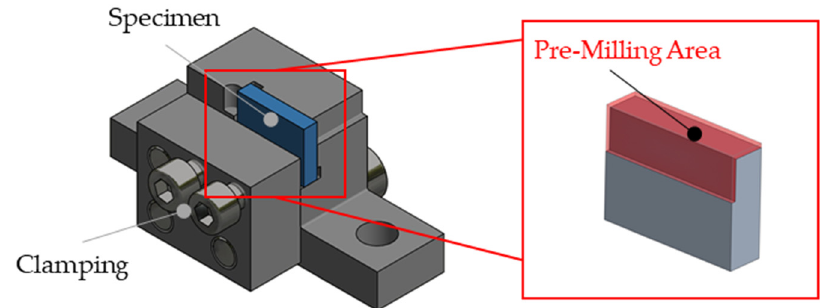
Figure 10. Clamping fixture ( left ) and pre-milling ( right ).